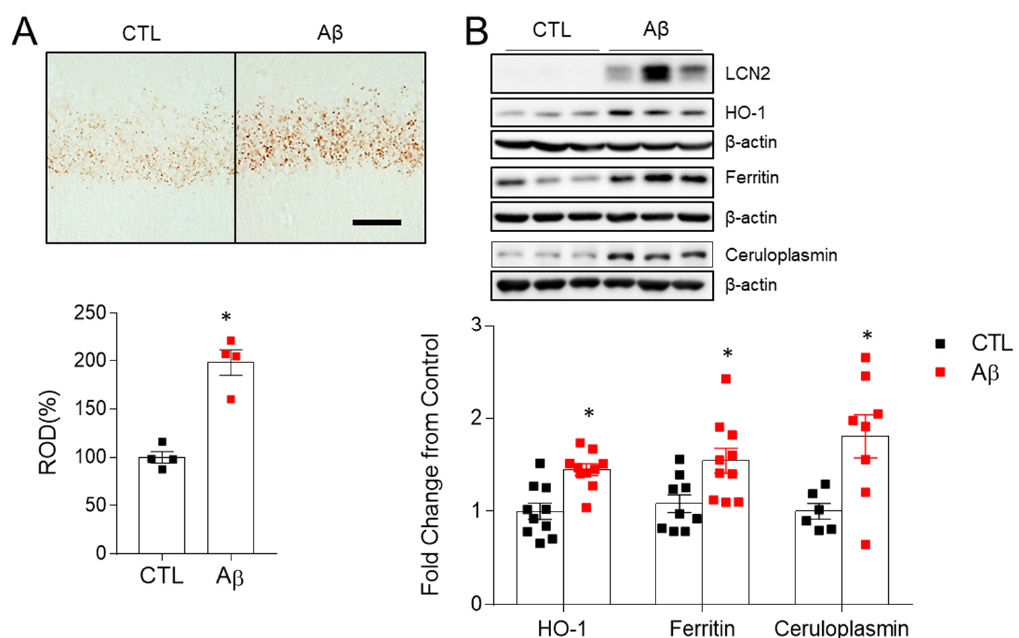
Figure 6. Effects of A β O toxicity on iron accumulation and oxidative stress in the hippocampus. ( A ) Histological staining ( × 100) for iron with DAB-enhanced Perls’ staining in the hippocampal CA1 regions and relative optical density (ROD) measurements (%). Scale bar = 25 µ m. ( B ) Western blots and quantified hippocampal HO-1, Ferritin, and Ceruloplasmin expressions. β -actin was used as a loading control. As shown in Figure 5A, A β O-induced LCN2 is also enhanced in same Western blot used in HO-1. The data are presented as mean ± SEM. * p < 0.05 for control compared with A β O-treated mice.